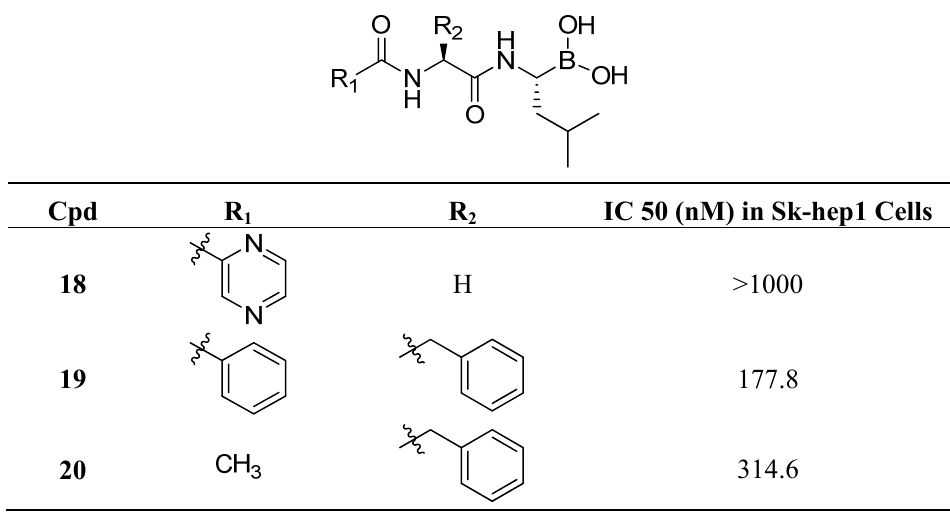
of growth inhibition in Sk-hep-1 cells. 50